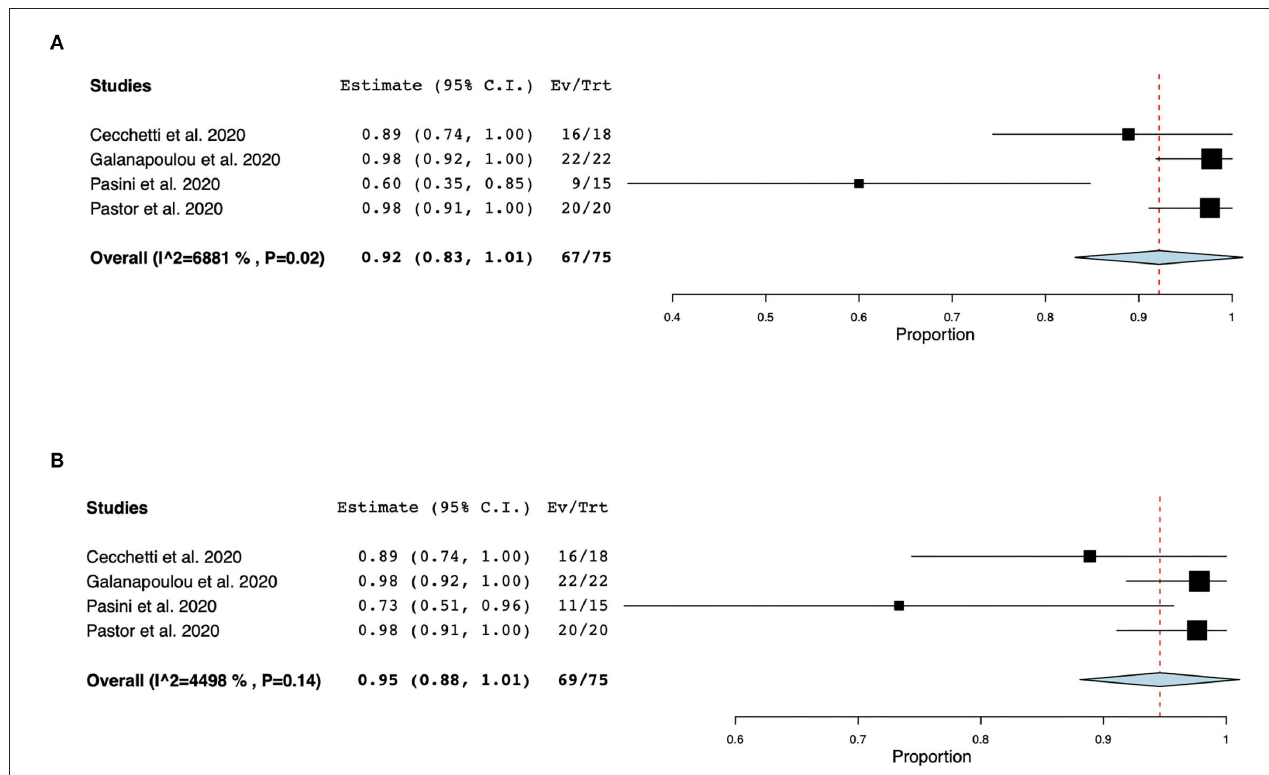
FIGURE 4 | Forest plots of slow background (theta and delta) and abnormal background abnormalities. The pooled prevalence of slow background abnormalities was 0.92 (95% CI 0.83–1.01, SE 0.05, p < 0.01), τ 2 0.01, Q (df = 3) 9.62, p < 0.02, I 2 = 68.81 (A) . The pooled prevalence of abnormal background in non-ICU COVID-19 patients was 0.95 (95%CI 0.88–1.09, SE 0.03, p < 0.01), τ 2 0.0, Q (df = 3) 5.45, p = 0.14, I 2 44.98 (B) .